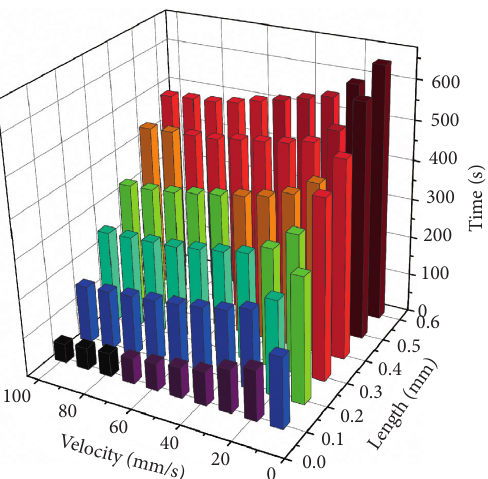
Figure 14: The variation of lysis time over different injection velocities and various clot